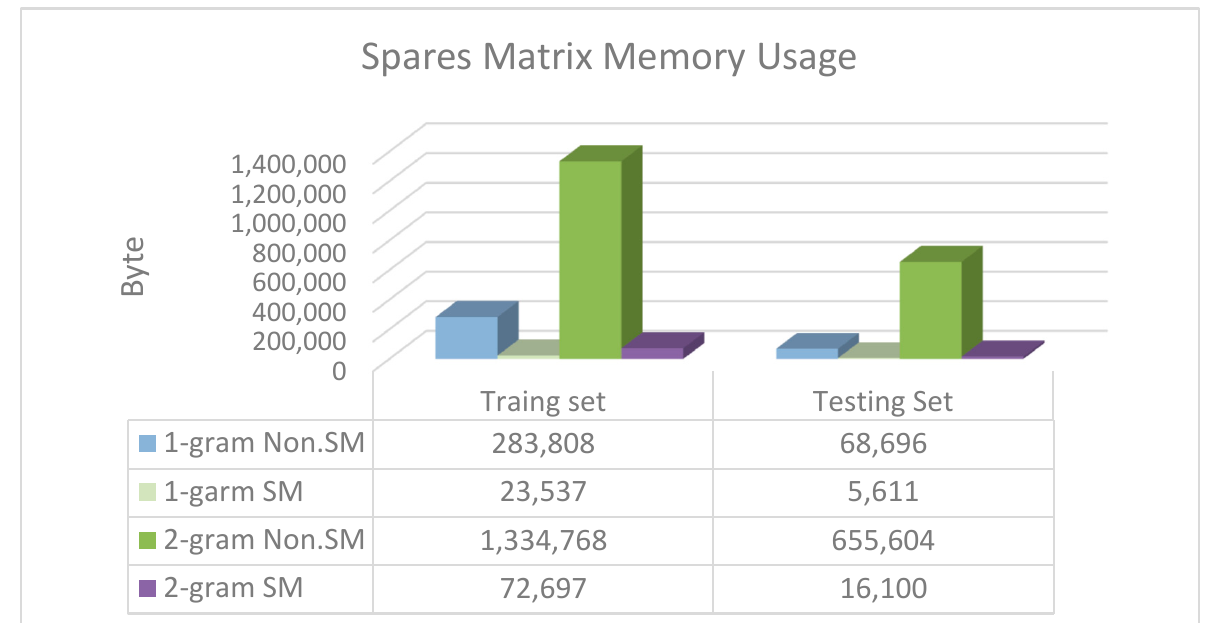
Figure 8. Sparse matrix memory usage.